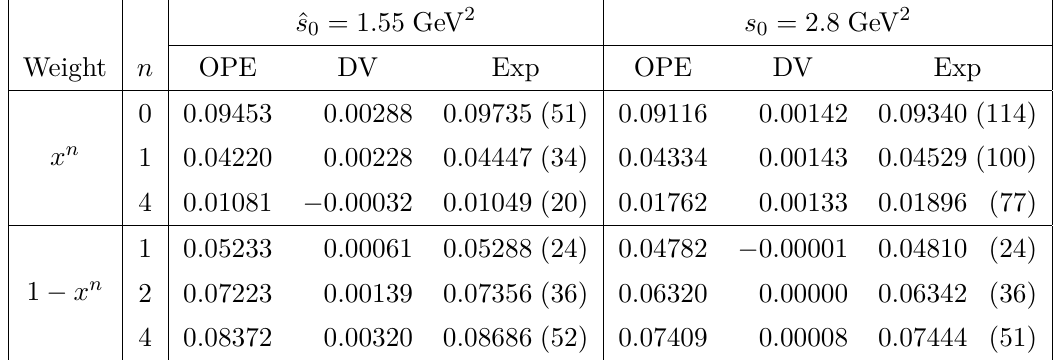
Table 6 . Separate values of the OPE and DV contributions to A ω n experimental moments, for the relevant weights ω The splitting is shown at the scales ˆ s